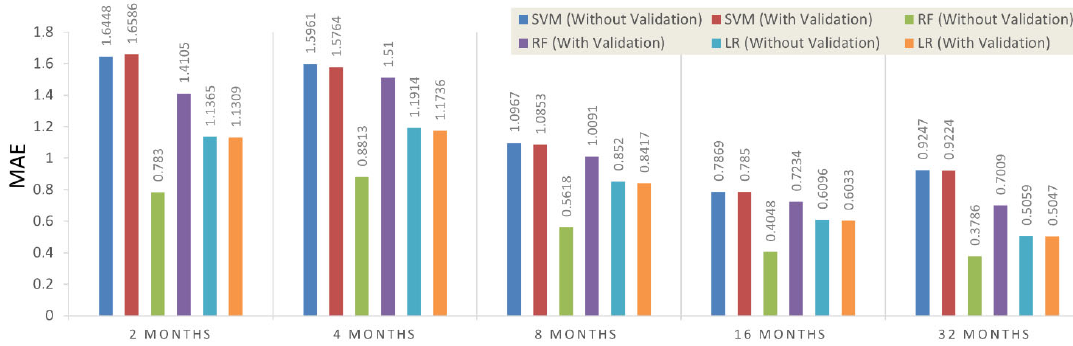
Figure 9. Graphic of MAE results.